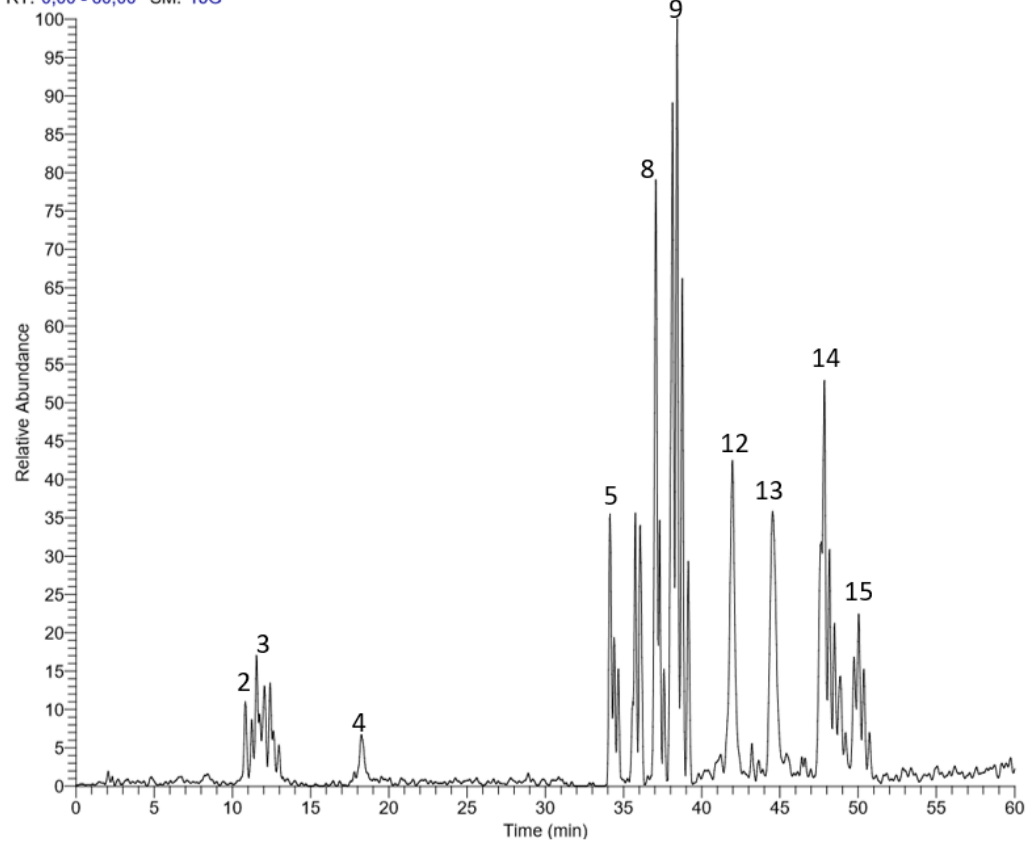
Figure 1. LC–MS profile of Haematoxylon campechianum flower extract.